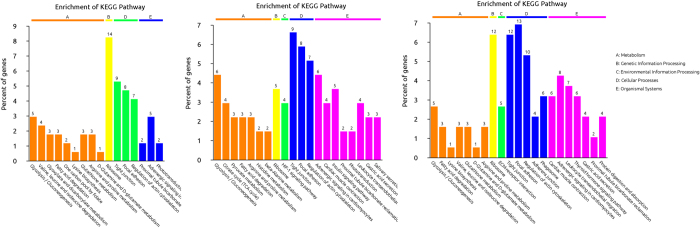
Most significant associated KEGG pathways of differentially expressed proteins at each time point.(A) 24 h; (B) 48 h; and (C) 96 h.